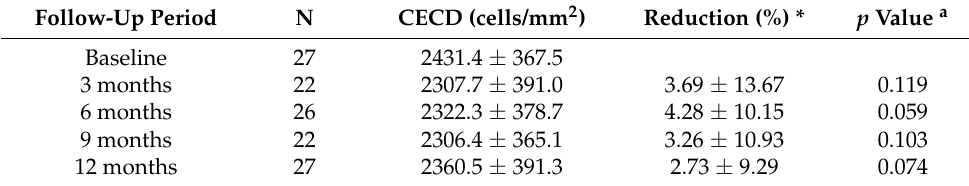
eyes, the mean decrease in the CECD at 12 months was 24.3 ± 168.2 cells/mm 2 (reduction rate of 1.81 ± 8.39%). Table 2. Comparison of CECD in eyes treated by AGV